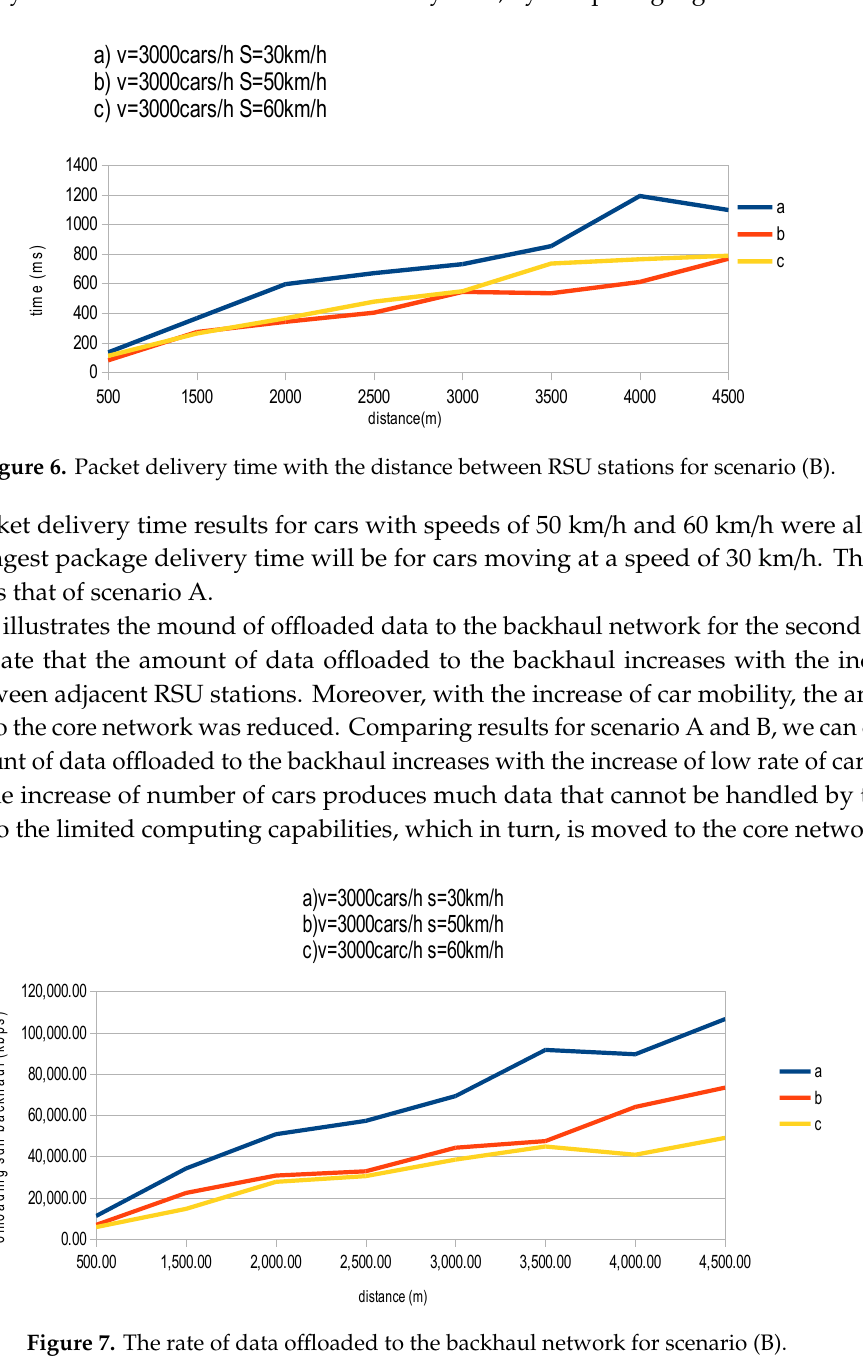
Figure 7. The rate of data offloaded to the backhaul network for scenario (B).